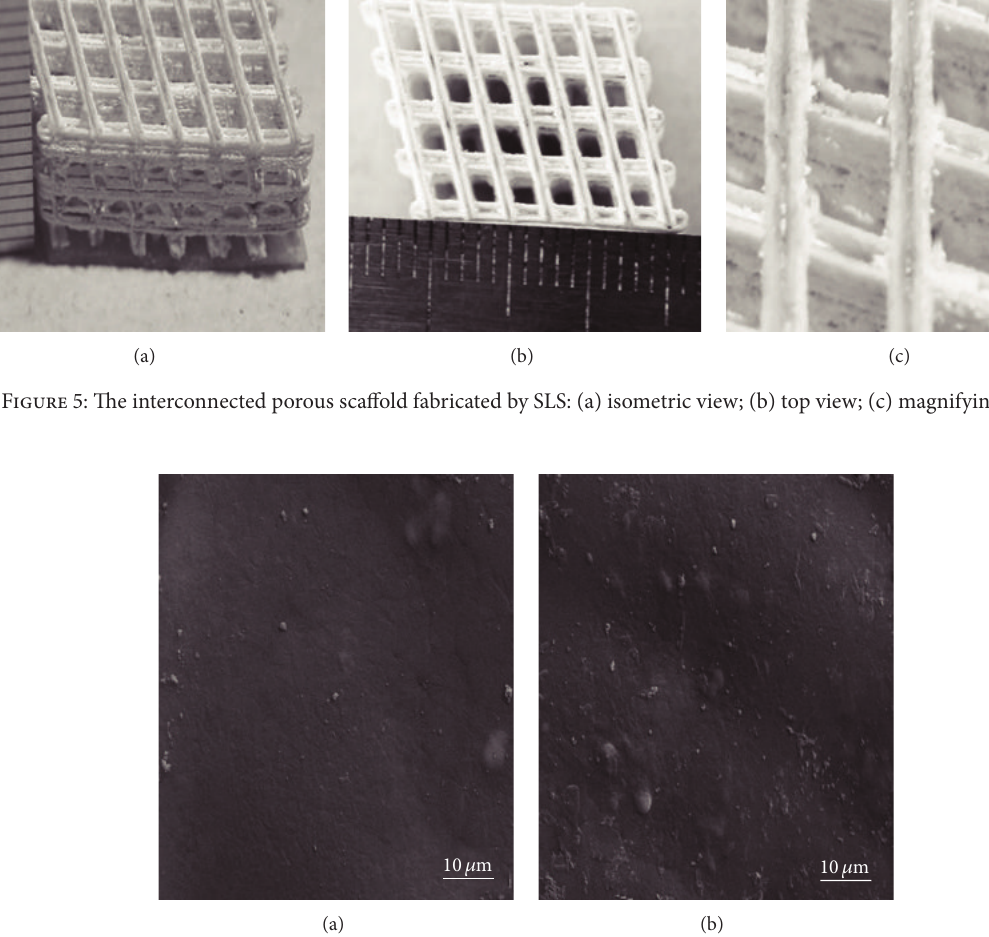
Figure 6: PVDF scaffolds immersed in SBF for different days: (a) 7 days; (b) 14 days.